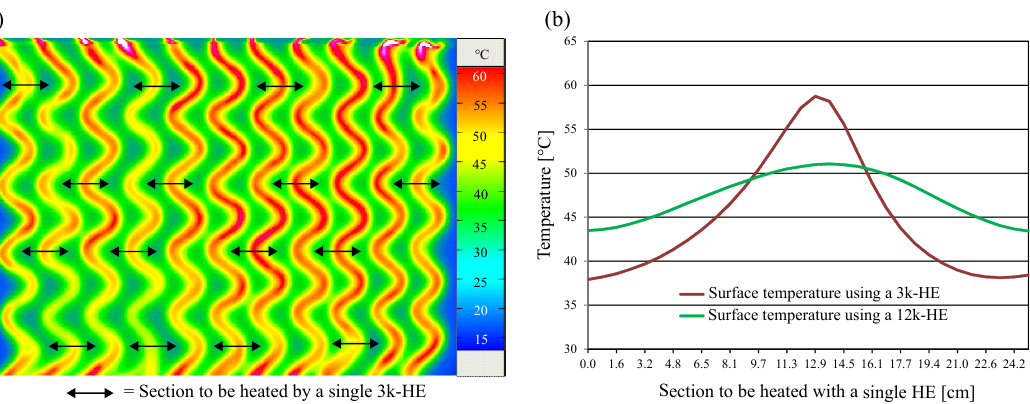
Figure 5. ( a ) Thermogram of the textile surface of the sample warming system with 3k-HE; and ( b ) comparison of the experimentally determined surface temperatures using 3k- and 12k-HE.